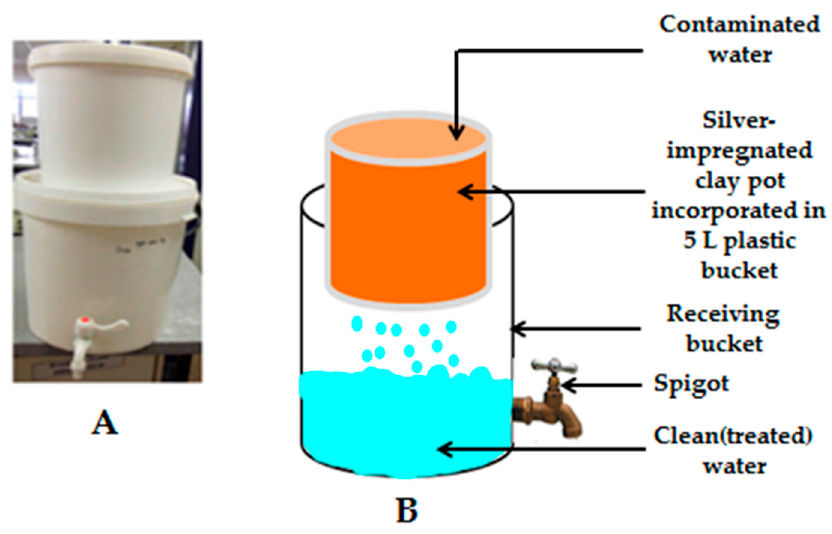
Figure 2. ( A ) Silver-impregnated porous pot (SIPP) filter; ( B ) Schematic representation of the SIPP filter. Adapted from